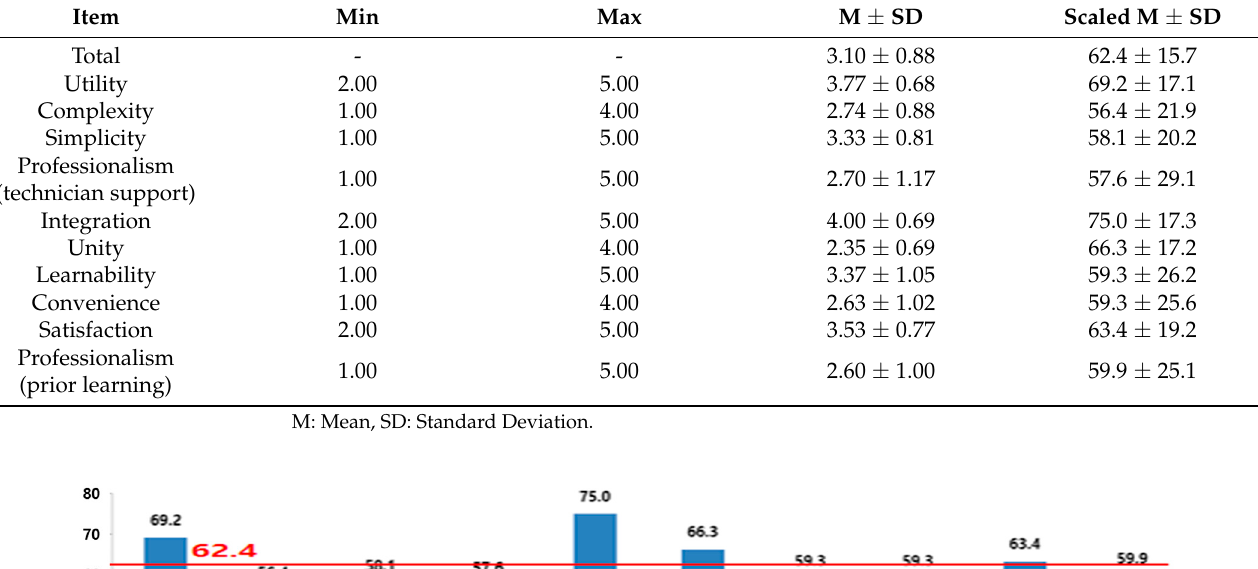
Table 5. SUS evaluation results. (N = 43, Unit: point).